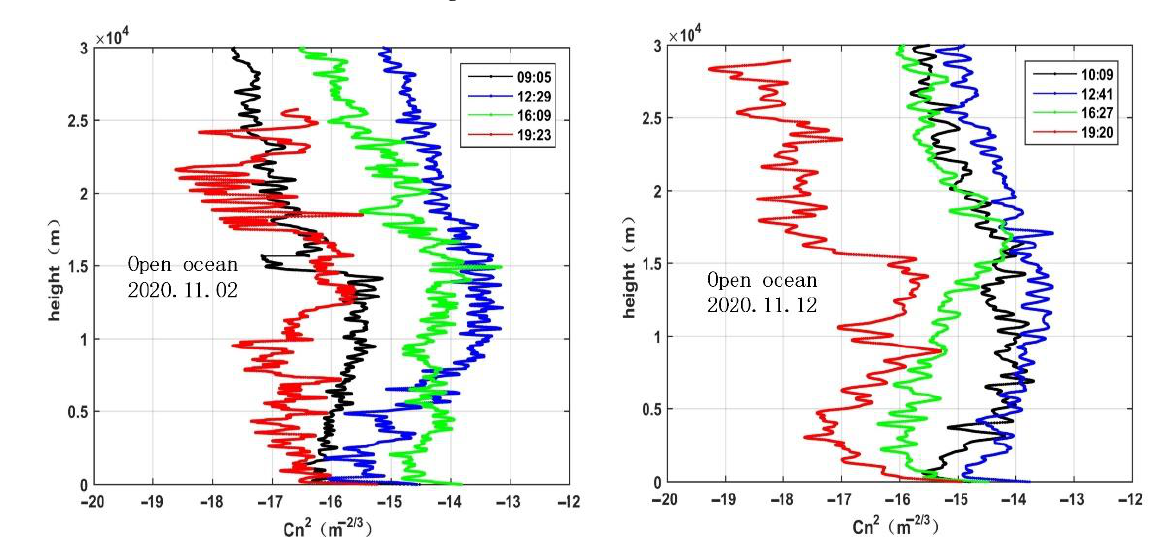
C over the open ocean. Figure 3. Vertical profiles distribution of C 2 n over the open ocean. n